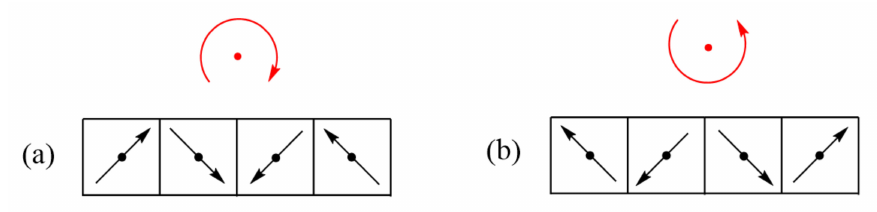
Figure 14. ( a , b ) Two cycloids, which are opposite in chirality but are identical in